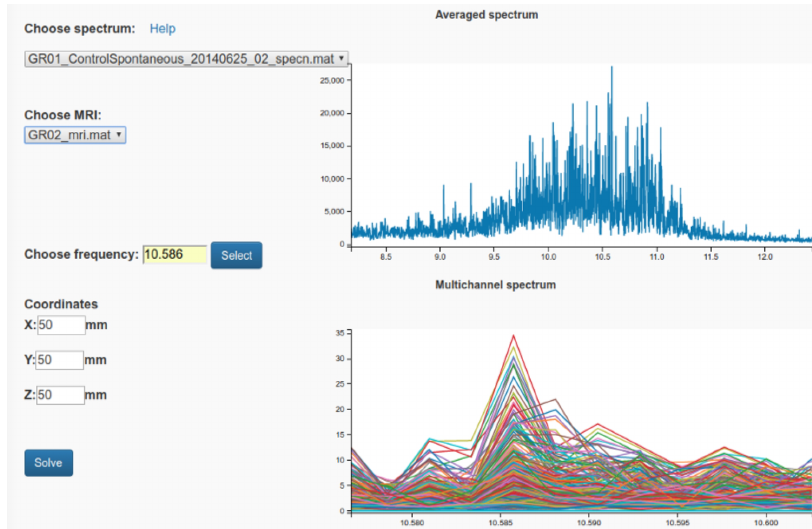
Figure 2. “Inverse MEG problem” method input data